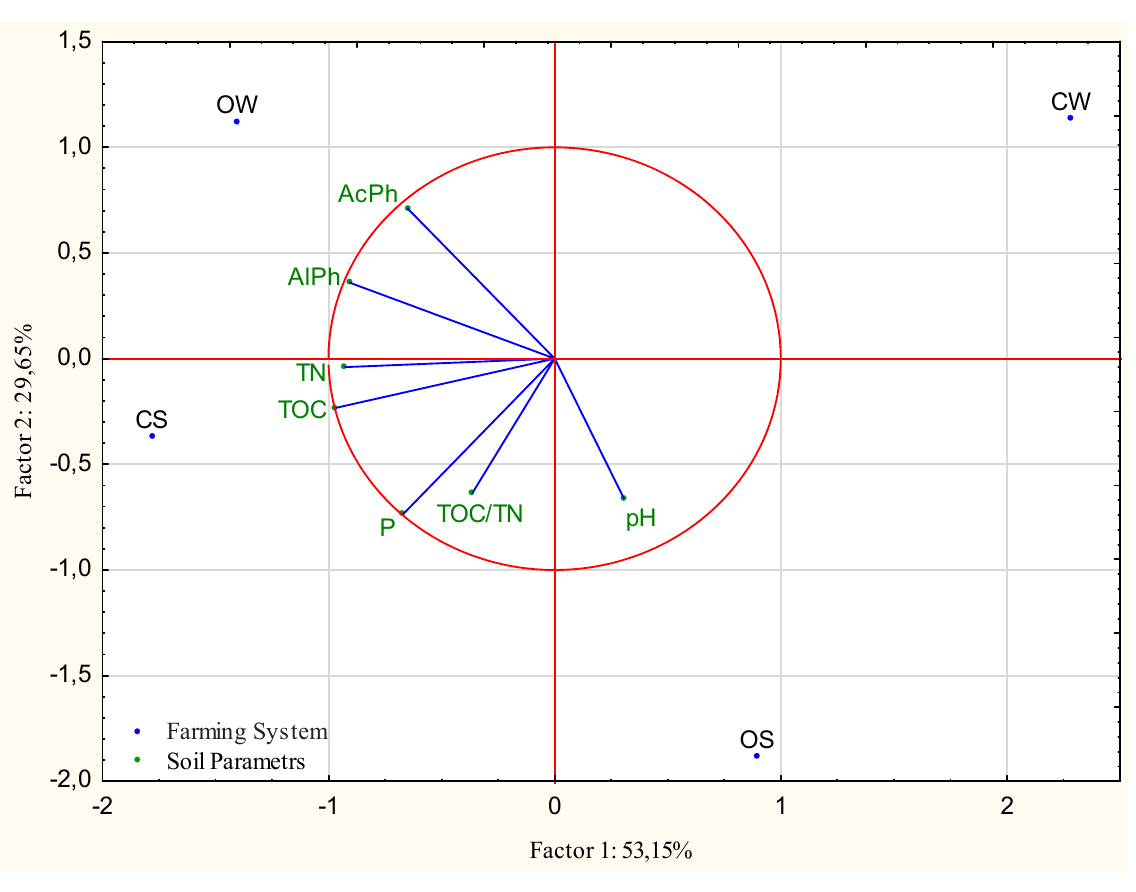
Figure 3. Biplot. Projection of variables on a plane of the first and second factor. Farming system and crop plant: CW, OW, CS and OS (explanation in Table 5). Soil parameters: pH—pH in 1 mol · dm − 3 KCl; TOC—total organic carbon; TN—total nitrogen; TOC/TN—TOC/TN ratio; AlPh—activity of alkaline phosphatase; AcPh—activity of acid phosphatase .